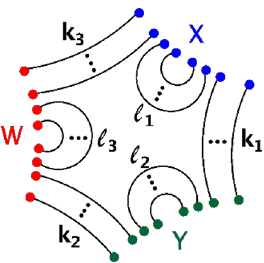
Figure 3 . The leading reparametrization mode exchanges in the six-point Virasoro identity block at large c in the ‘hefty’ regime where h X (cid:24) h Y (cid:24) h W (cid:24) O ( c 1 = 2 ). All diagrams of this form contribute at O ( c 0